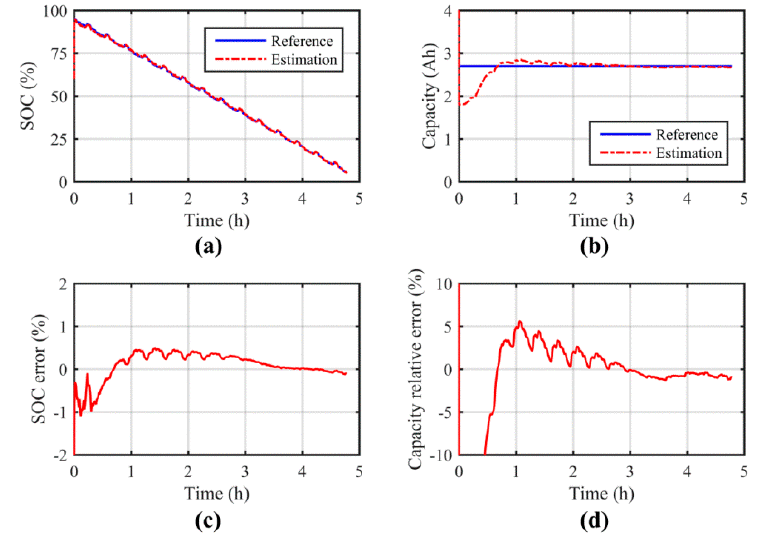
Figure 5. Results of SOC and capacity joint estimation under the HPT simulation study: ( a ) estimation of SOC; ( b ) estimation of capacity; ( c ) error of SOC estimation; ( d ) relative error of capacity estimation.